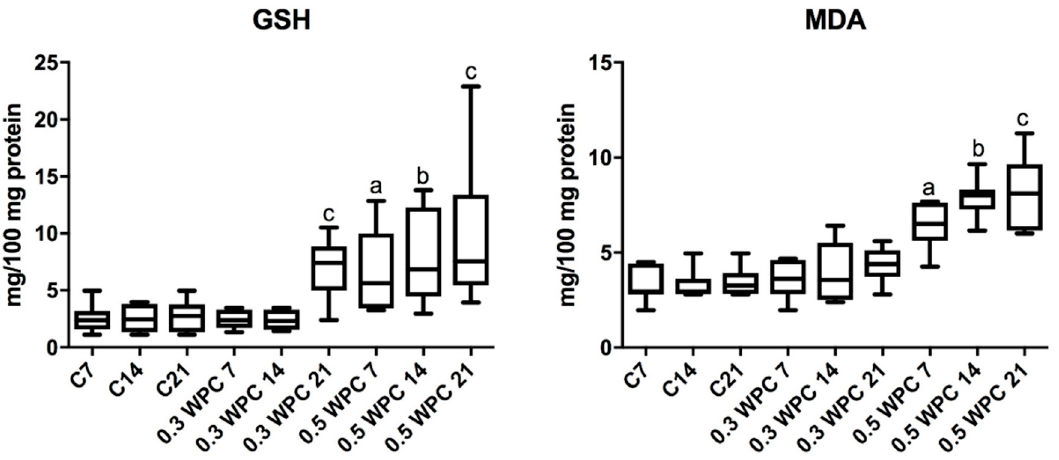
Figure 5. Reduced glutathione (GSH) and malondialdehyde (MDA) concentrations in the liver of WPC-80-fed rats and the control group. C7, C14, C21, control groups; 0.3 WPC 7, 0.3 WPC 14, 0.3 WPC 21, 0.5 WPC 7, 0.5 WPC 14, 0.5 WPC 21, experimental groups. Differences statistically important: a vs C7; b vs C14; c vs C21 ( p < 0.05).